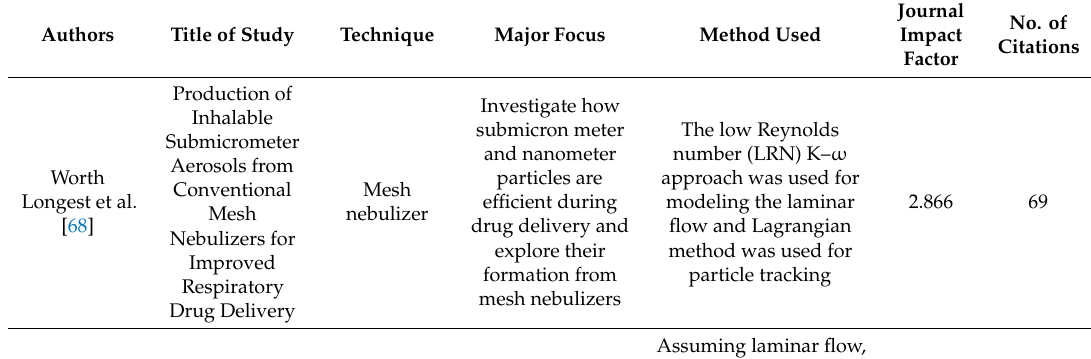
Table 2. Summary of literatures on influencing factors of